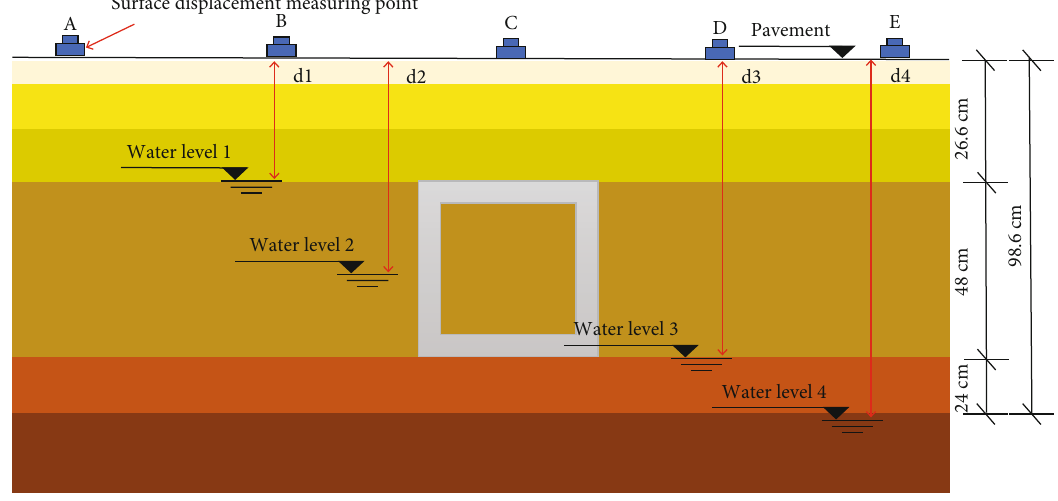
Figure 5: The relationship between groundwater level and buried depth of pipe gallery.